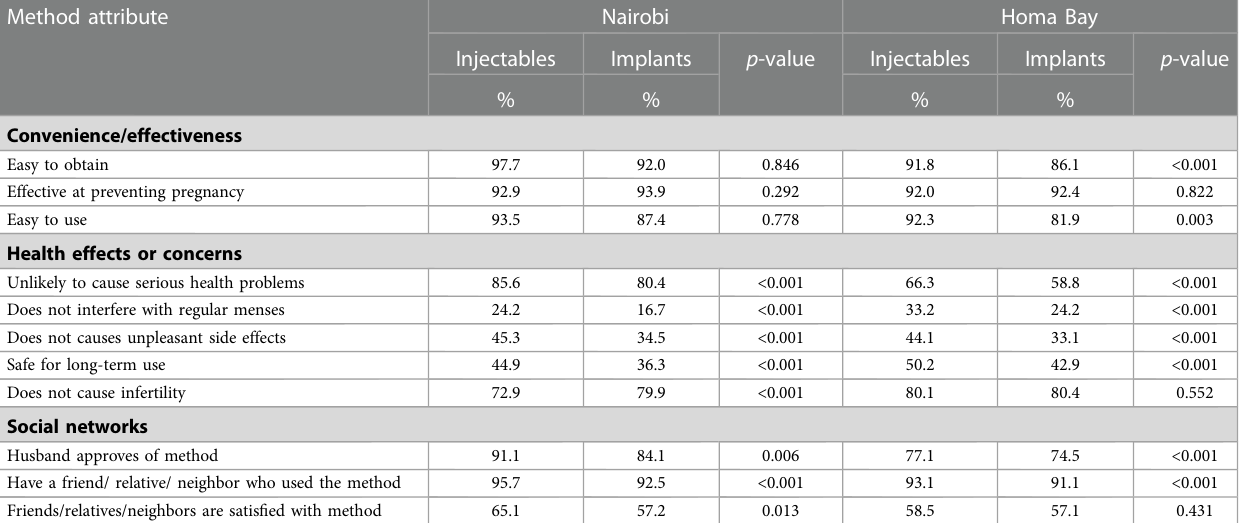
TABLE 4 Beliefs about the methods among current users of injectables and implants at round